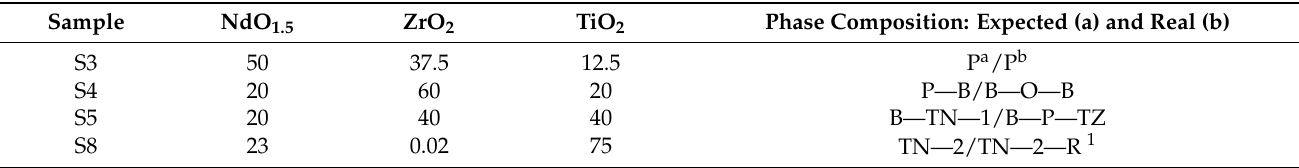
present according to XRD and SEM/EDS studies [148].